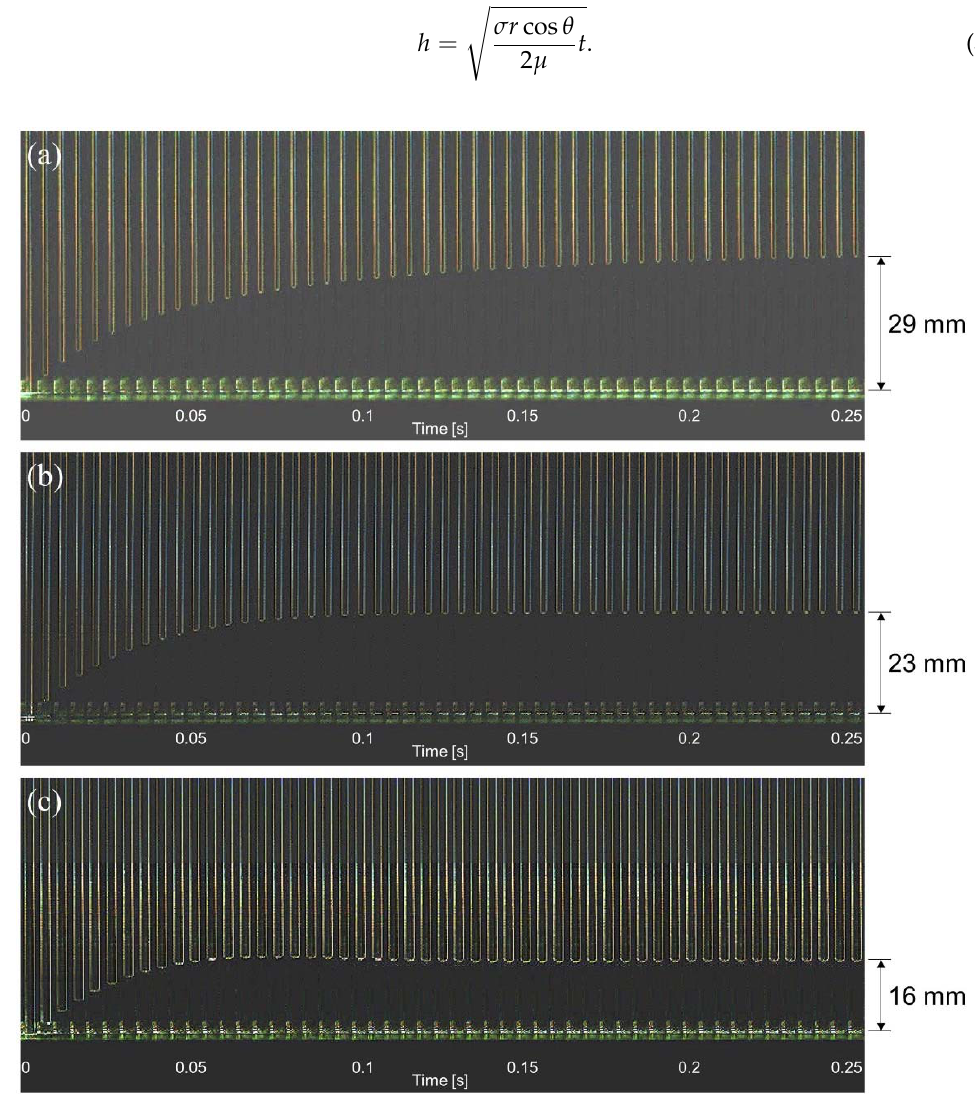
Figure 4. Time series of direct photographs for DW showing the height with different tube radii. ( a ) 0.4 mm, ( b ) 0.6 mm, and ( c ) 0.85 mm.